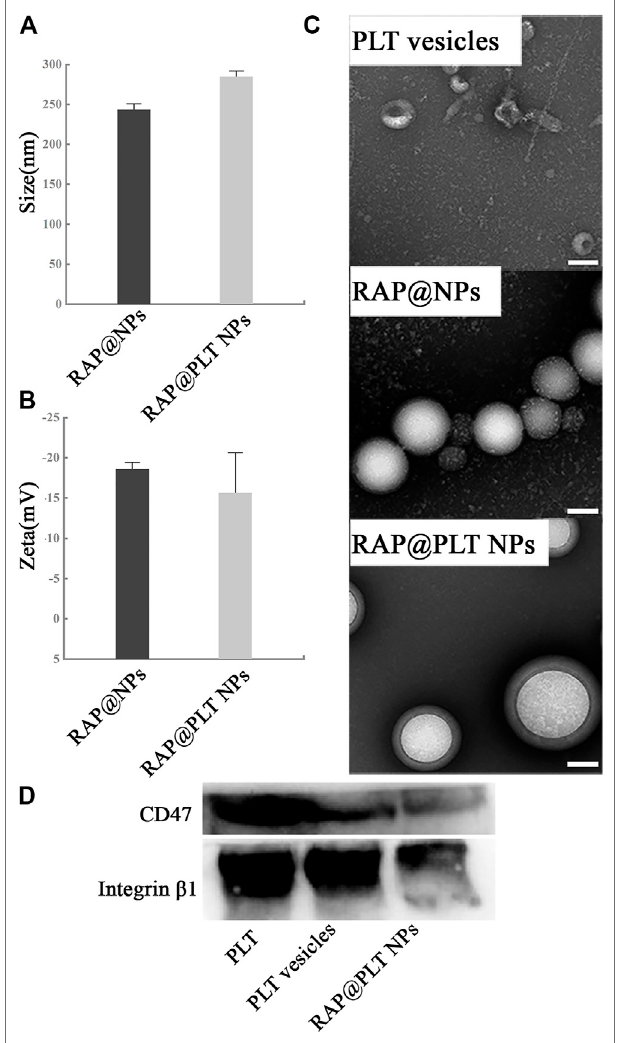
FIGURE 2 | Characterization of RAP@PLT NPs. (A) Size and (B) Zeta potentialofRAP@NPsand RAP@PLT NPs(before and after coating withPM). (C) The TEM image of platelet vesicles. Scale bar: 100 nm. (D) Representative CD47 and Integrin β 1 protein bands of fresh PLT, PLT vesicles and RAP@PLT NPs resolved using Western